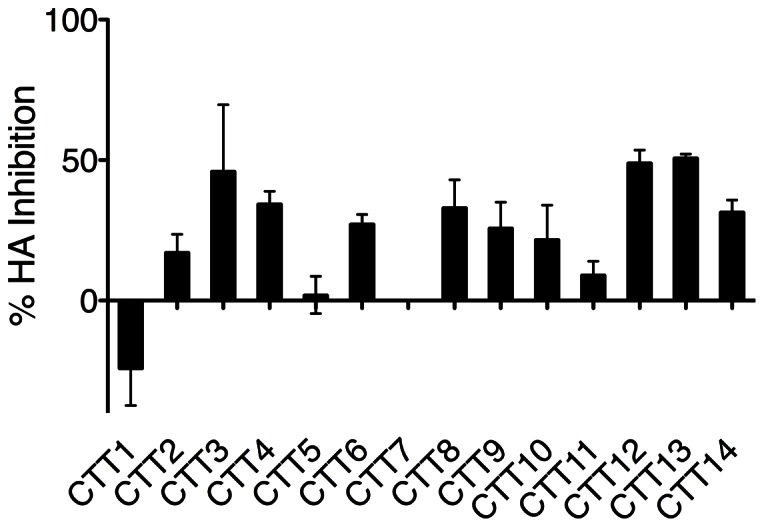
Inhibition of HA-specific antibody binding by VSV-G-specific antibody.Env-expressing cells were first reacted with unlabeled anti-VSV-G (CTT) antibody followed by staining with fluorescently-labeled anti-HA (gp120). The percent reduction in HA-labeled cells compared to HA-stained cells without VSV-G staining is presented as percent HA-inhibition.